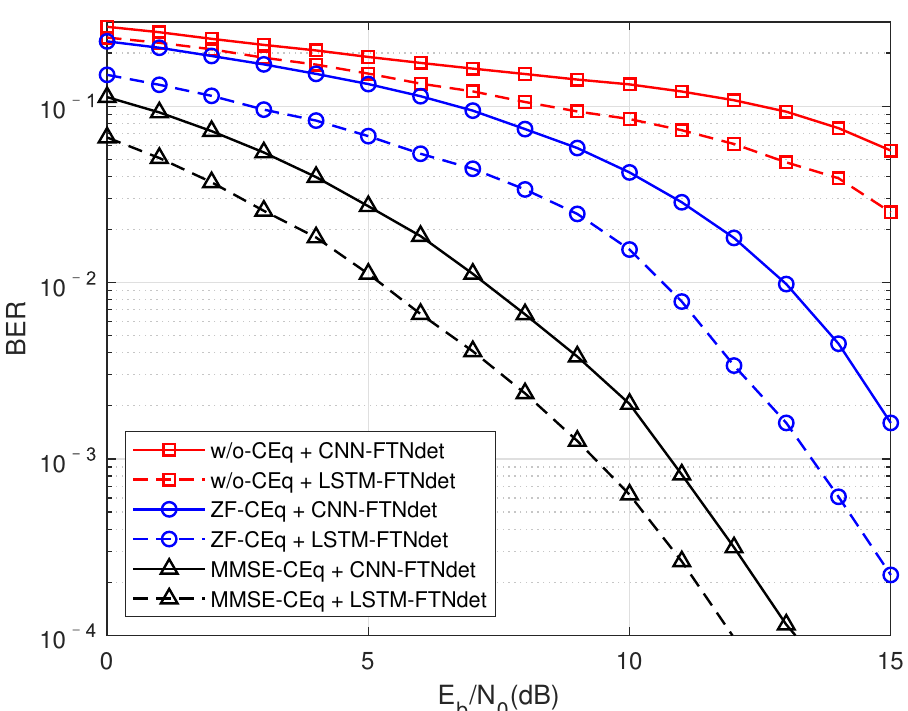
Figure 4. In the TU channel, when the compression factor τ = 0.7, compare the performance of different channel equalization